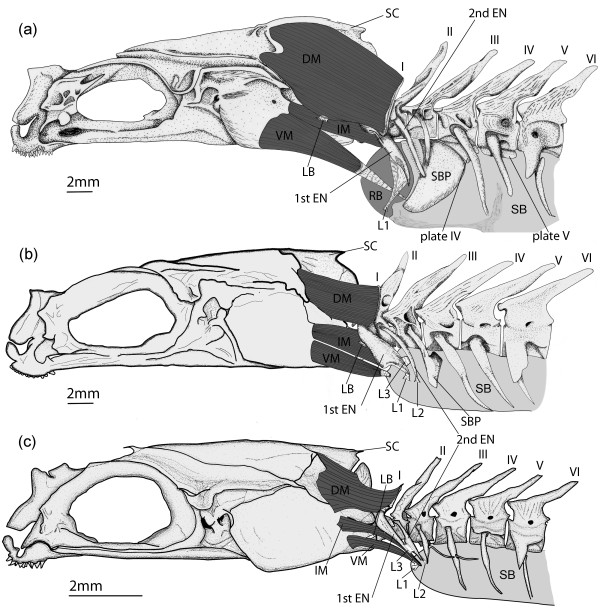
Morphology of hard and soft tissues in sonic apparatus of Ophidion rochei. Left lateral view of the sonic apparatus of (a) male, (b) female and (c) juvenile Ophidion rochei. The skull, the first modified vertebrae and ribs, and the 3 pairs of sonic muscles are shown. DM: dorsal sonic muscle, EN: epineural, IM: intermediate sonic muscle, L1-3: ligament 1–3, LB: ligament of Baudelot, RB: rocker bone, SB: swimbladder, SBP: swimbladder plate, SC: supraoccipital crest, VM: ventral sonic muscle.